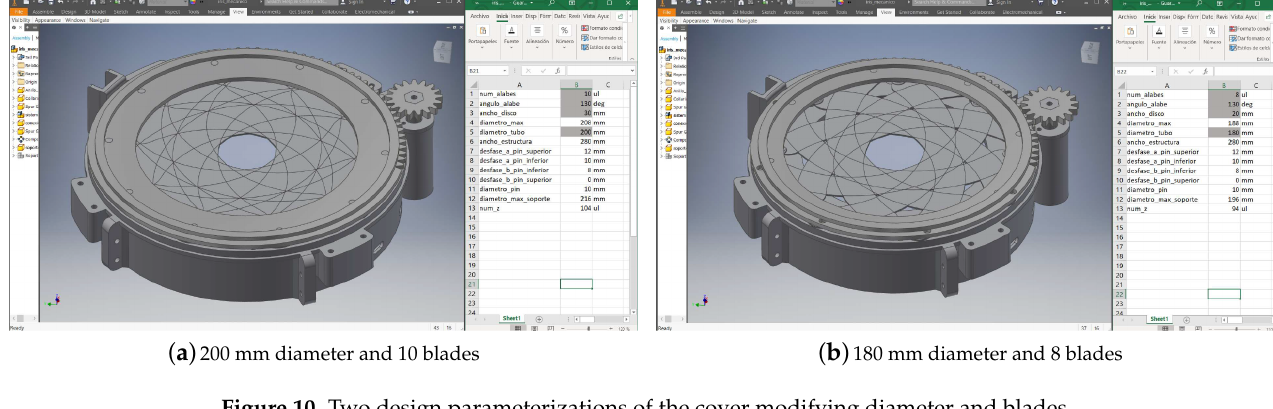
Figure 10. Two design parameterizations of the cover modifying diameter and blades.